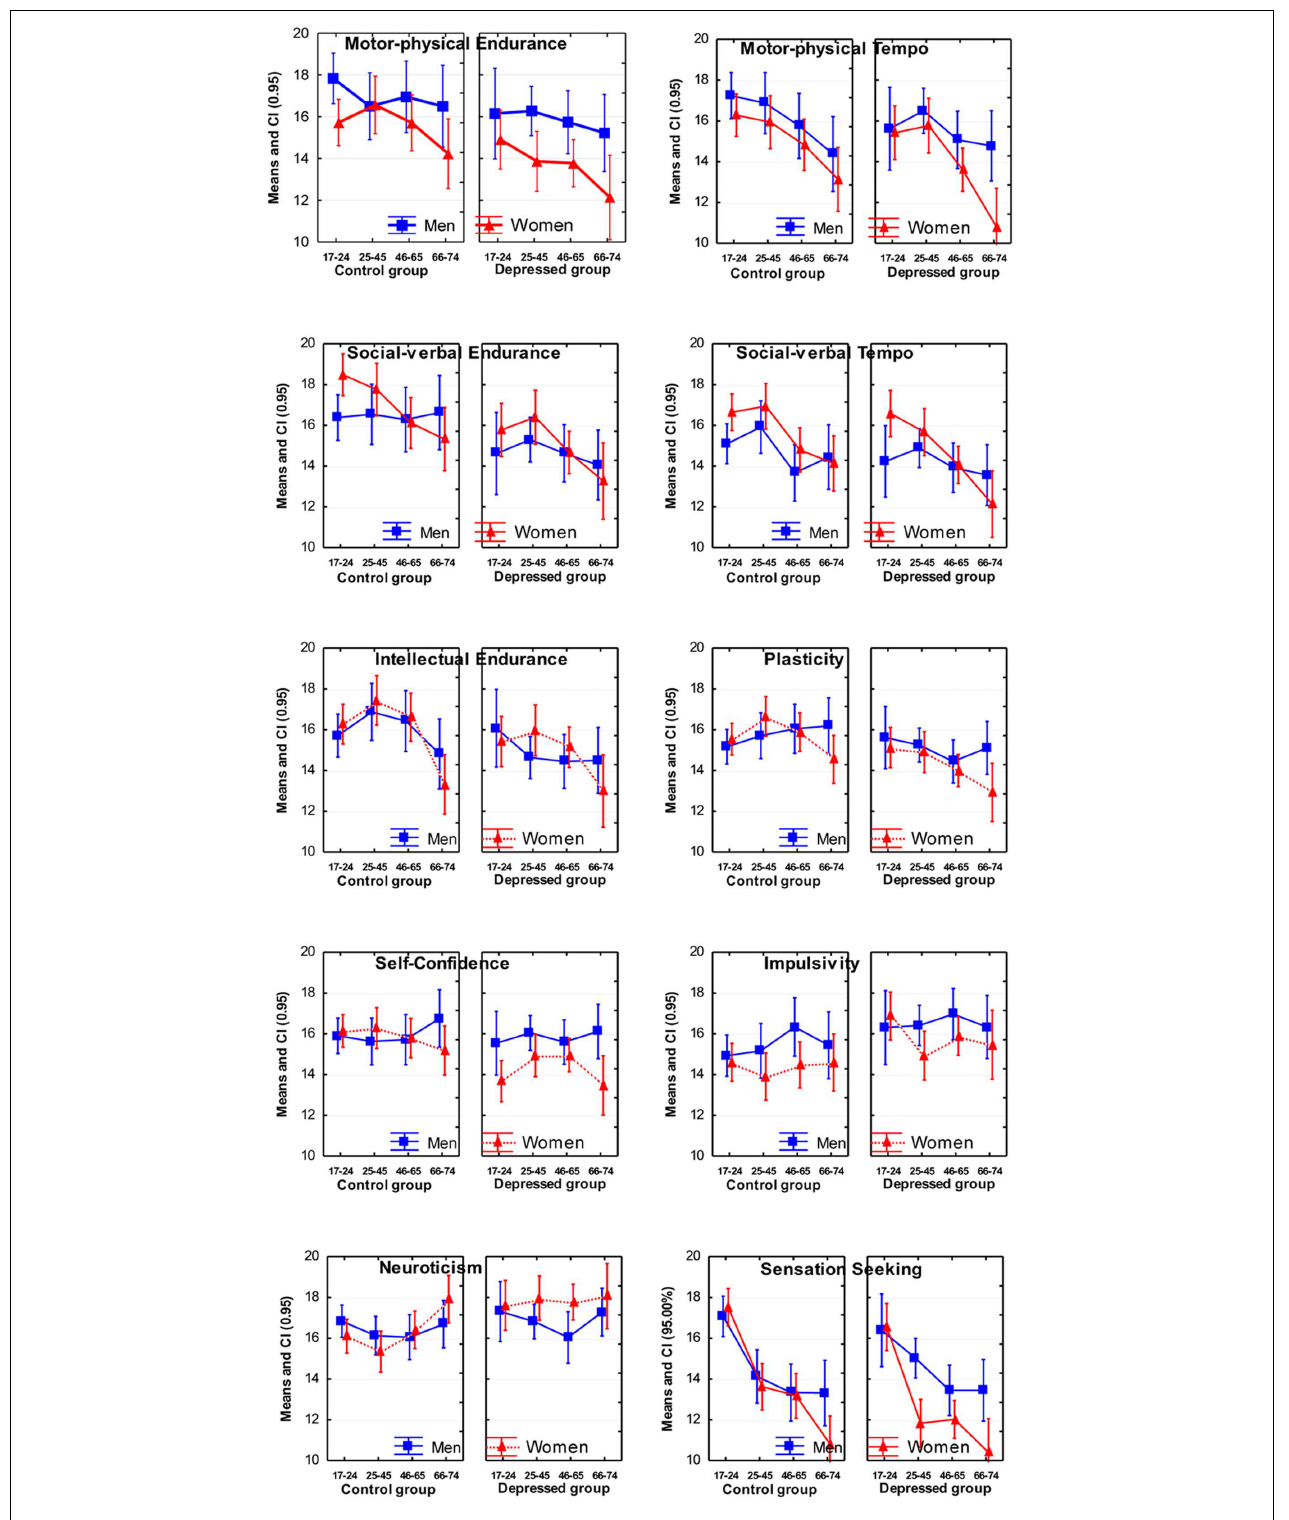
FIGURE 2 | Means and Confidence Intervals (CI; 95%) of the scores on temperament scales of the Structure of Temperament Questionnaire (STQ)-77.